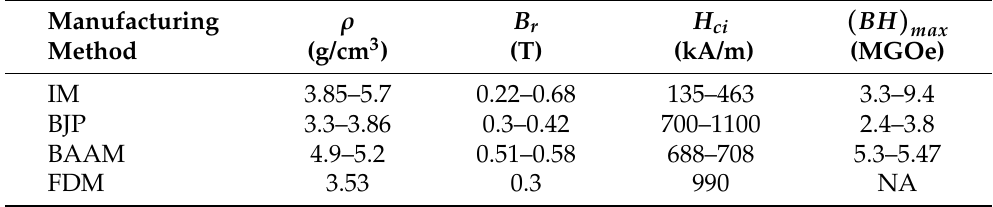
Figure 8. A comparison on thermal degradation of performance between commercial injection molded magnet and BAAM fabricated magnet. Figures are plotted using data in [56]. Table 2. Comparison of characteristics between commercial bonded magnets and additive manufac- tured NdFeB magnets